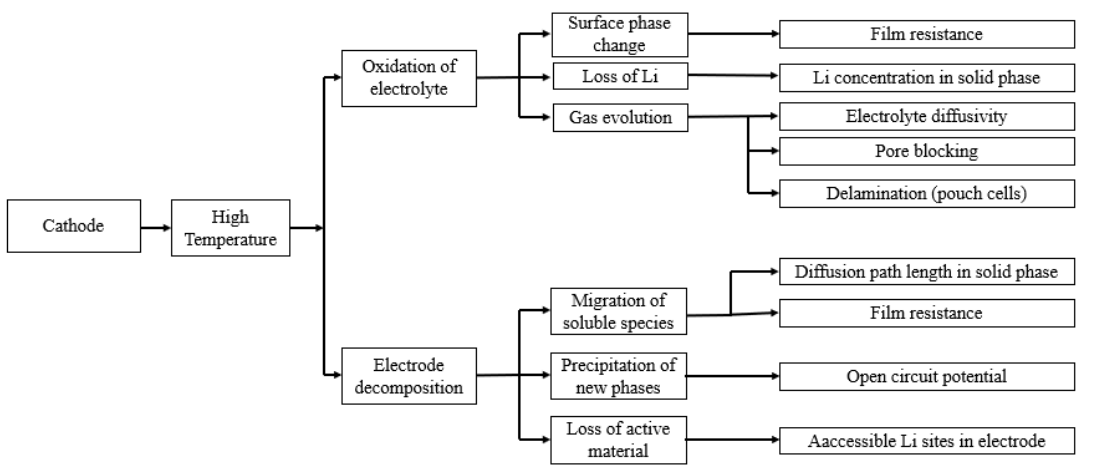
Figure 7. Schematic of the temperature effect on aging of the positive electrode (re ‐ elaborated from Uddin et al. [117]).